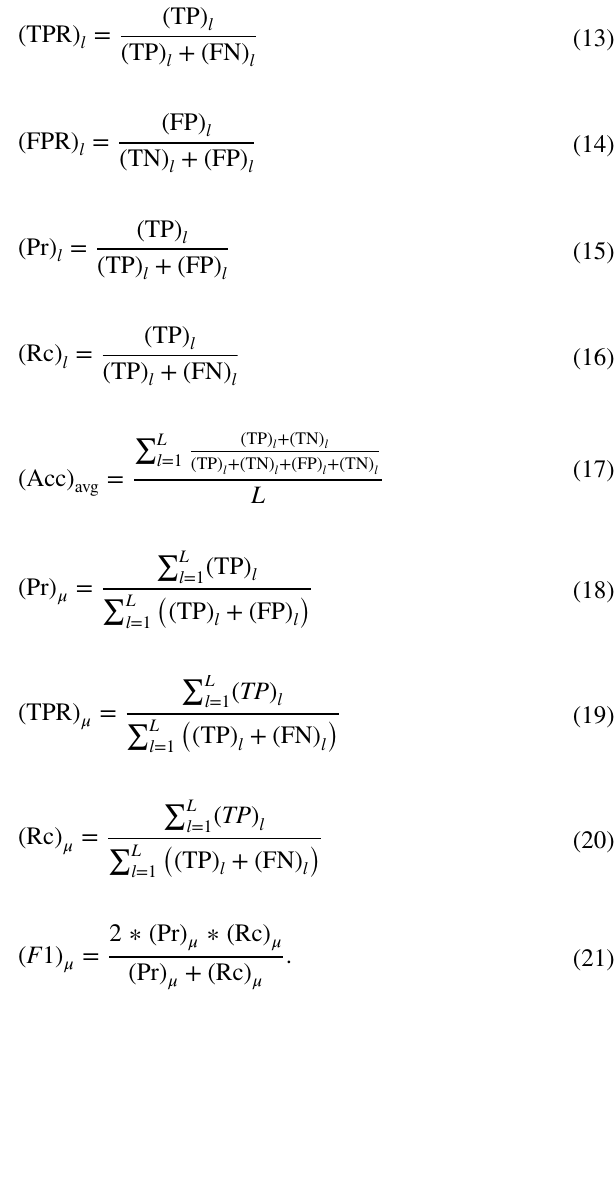
Table 1 The description of notations Notations